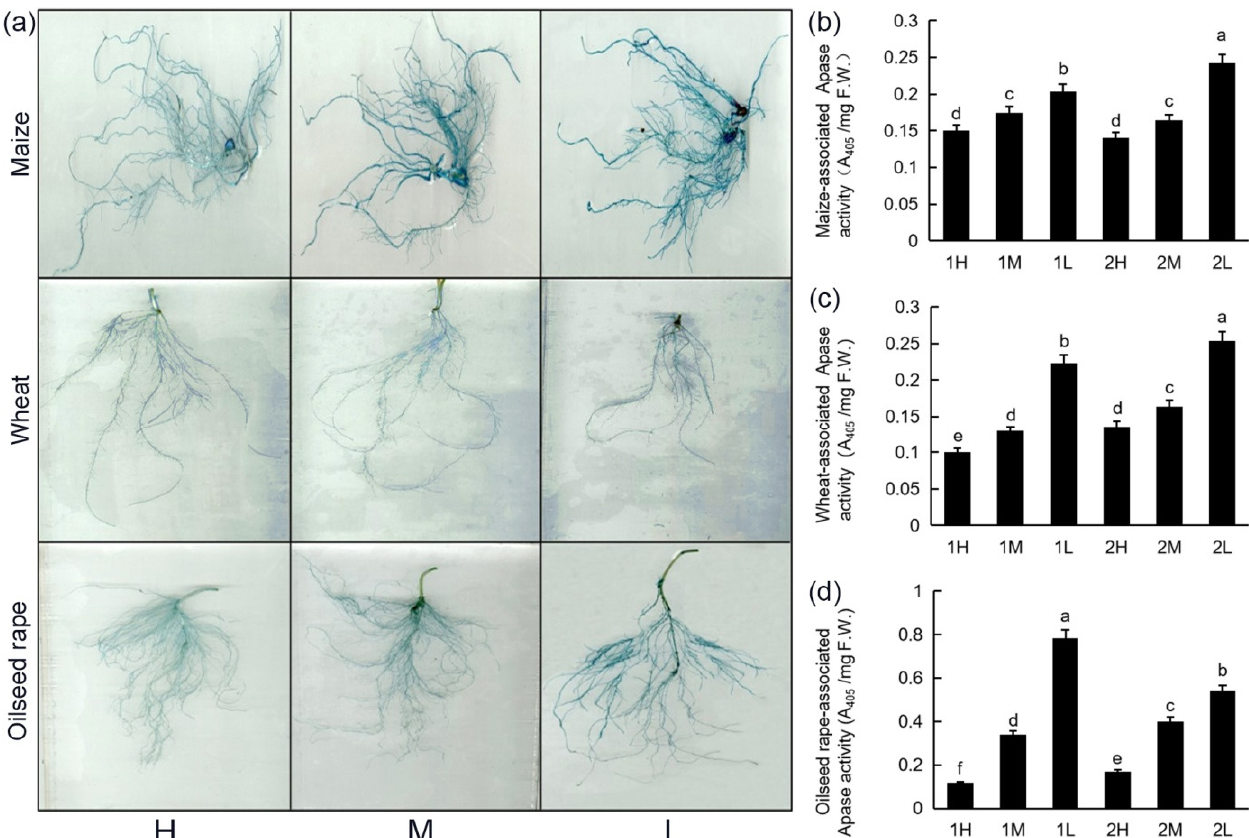
Figure 4. APase activities of plant roots under different light conditions: 20-day-old seedlings were subjected to one week of relatively high-light treatment (1H), one week of medium-light treatment (1M), one week of relatively low-light treatment (1L), two weeks of relatively high-light treatment (2H), two weeks of medium-light treatment (2M), or two weeks of relatively low-light treatment (2L). F.W.: fresh weight. APase staining of maize, wheat, and oilseed rape roots under high-light, medium-light, and low-light treatments ( a ). Quantitative analysis of APase activities of maize ( b ), wheat ( c ), and oilseed rape ( d ) roots. Bars represent standard deviations of 3 independent replicates (3 seedlings per replicate). Values followed by different letters are significantly different at p < 0.05 according to Duncan’s multiple range test.